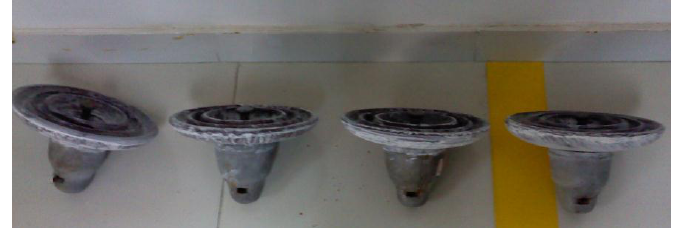
Figure 3. Artificially contaminated insulators used in experiments.